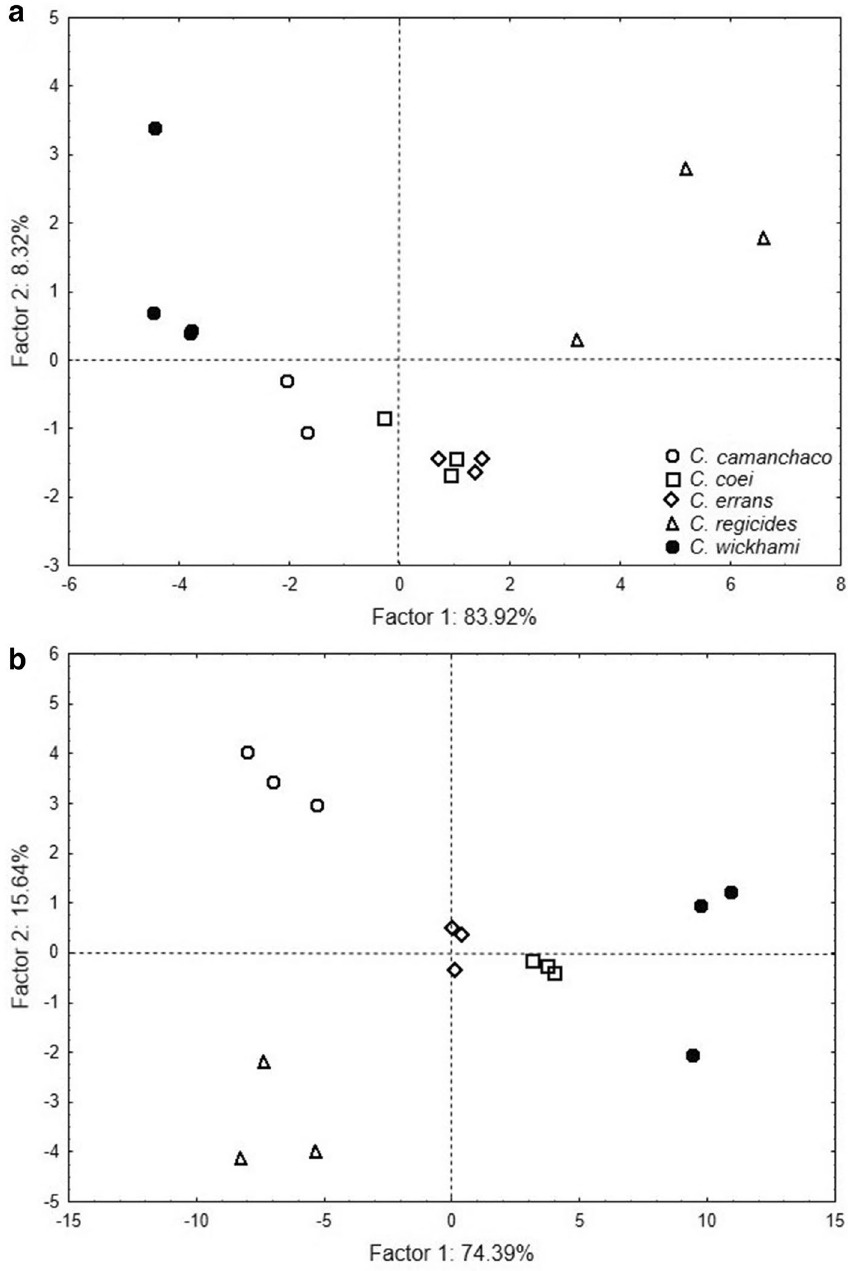
Figure 2. Principal components analysis based on morphometric measurements standardized by total length from five species of Carcinonemertes . ( a ) Female worms, ( b ) Male worms. White circles = C. camanchaco sp. nov., square = C. coei , diamond = C. errans , triangle = C. regicides , black circle = C. wickhami